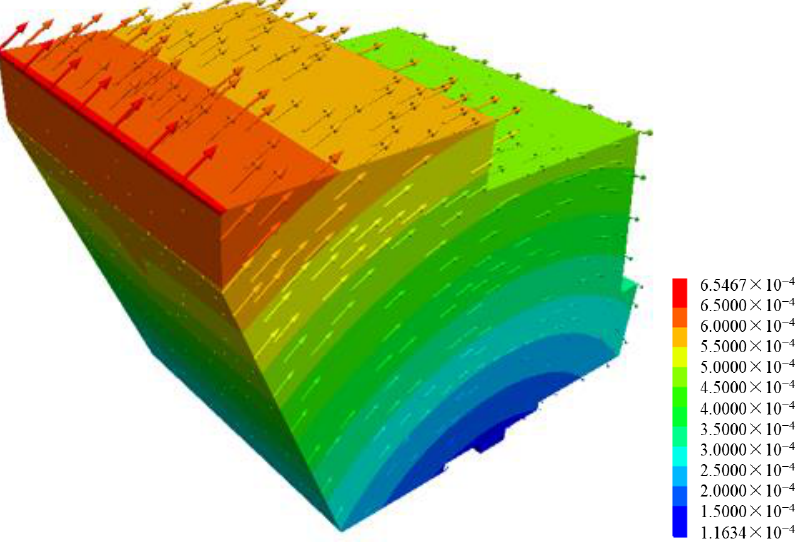
Figure 10. The displacement contour and the displacement vector of the bridge anchorage. (Unit in m).